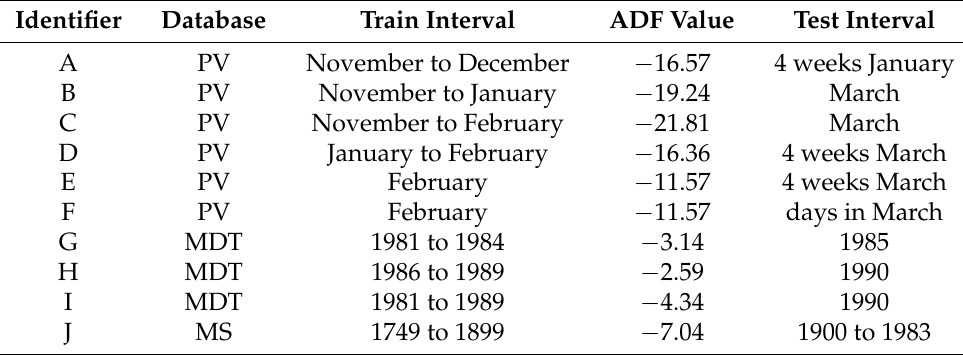
Table 2. Intervals used for experimentation from PV, MDT, and MS